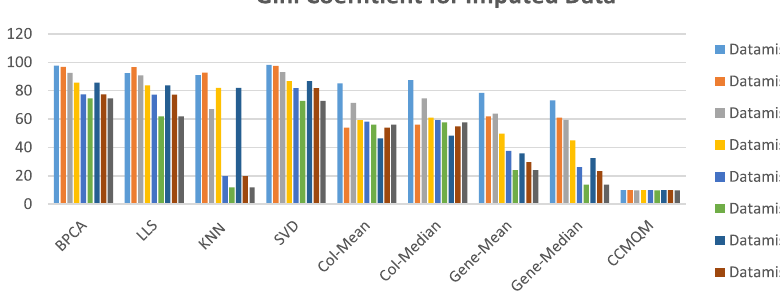
Fig. 3 Gini coefficient scores of imputation methods